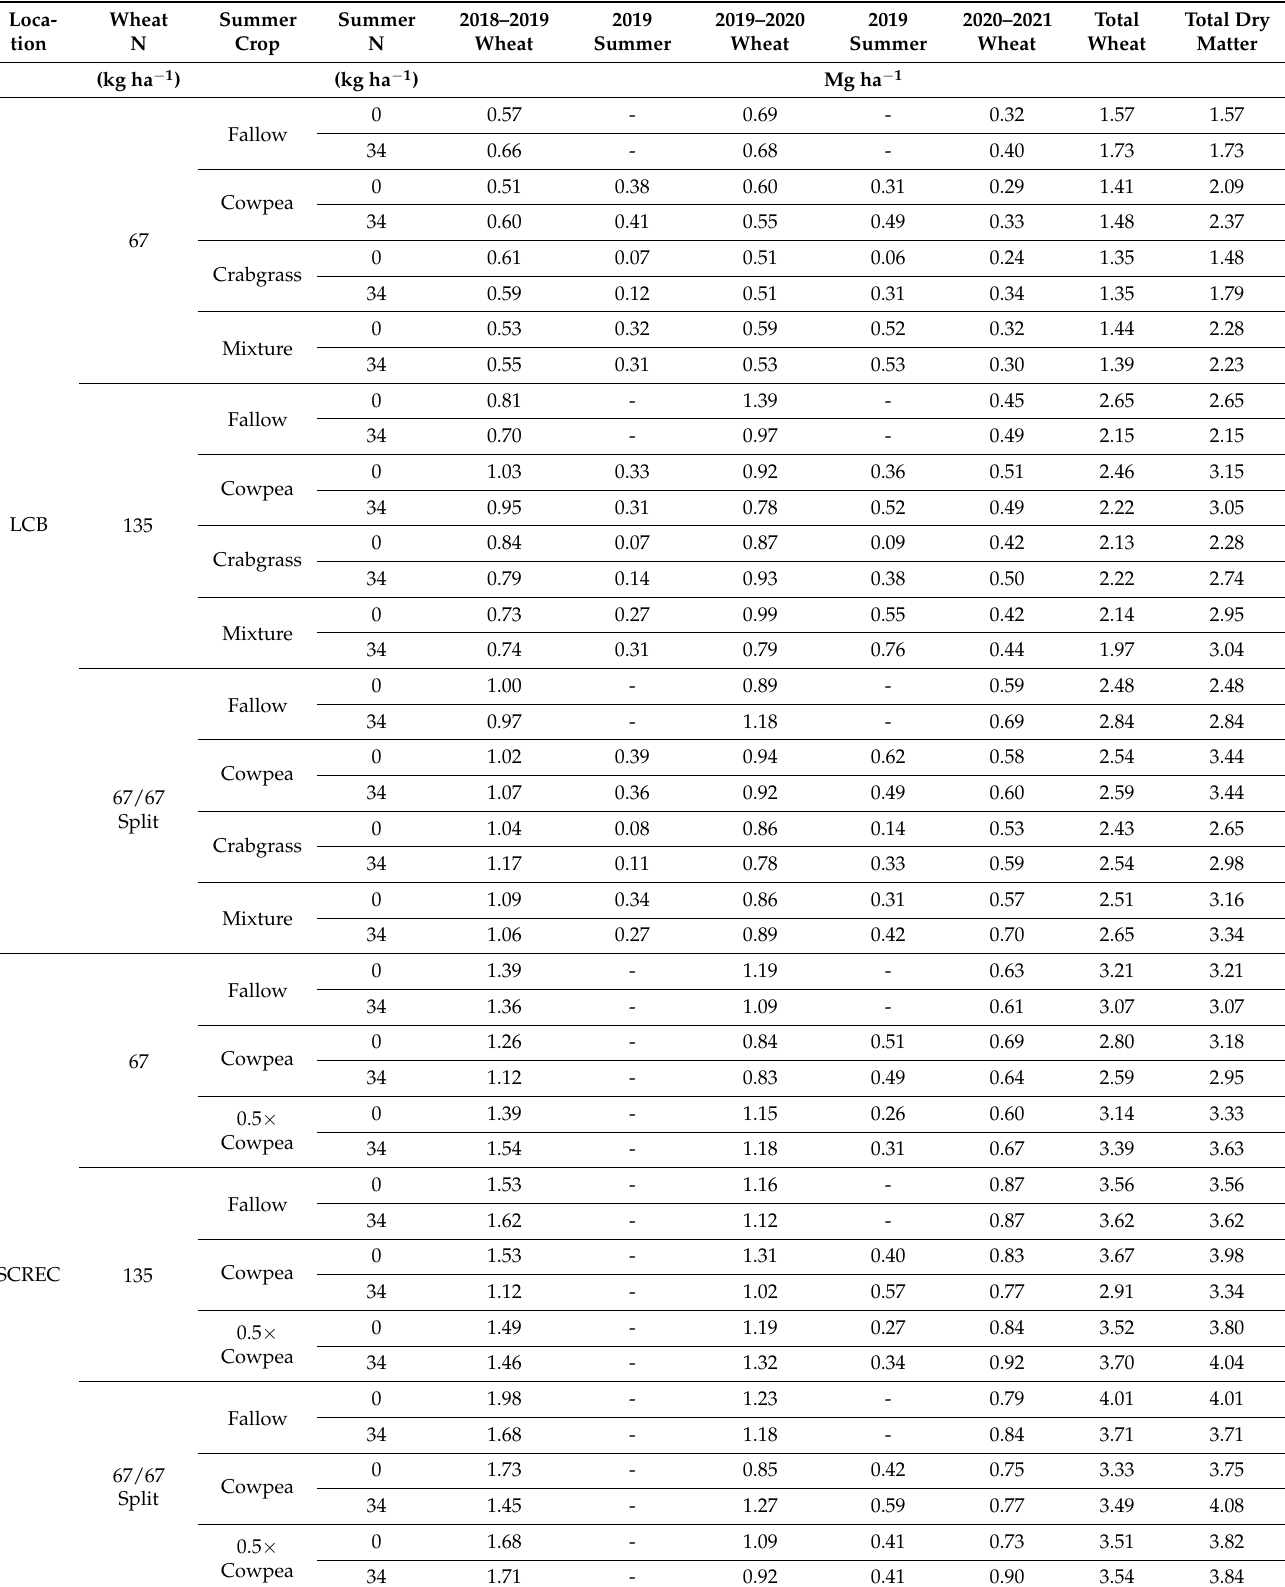
Table A2. Average crude protein yield production (Mg ha − 1 ) from each season of production for LCB and